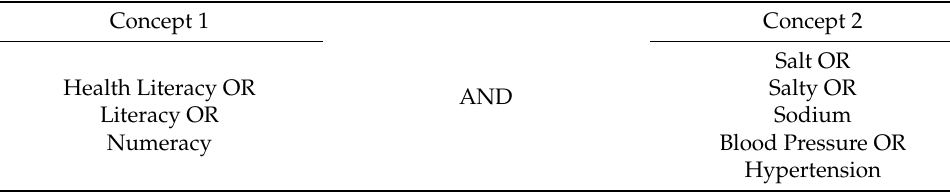
Table 2. Terms used for search